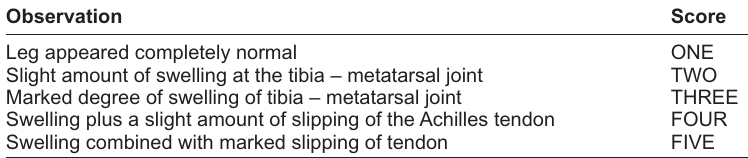
Table-2: Ingredients and nutrients composition (% DM) of broiler pre starter, starter and finisher diets